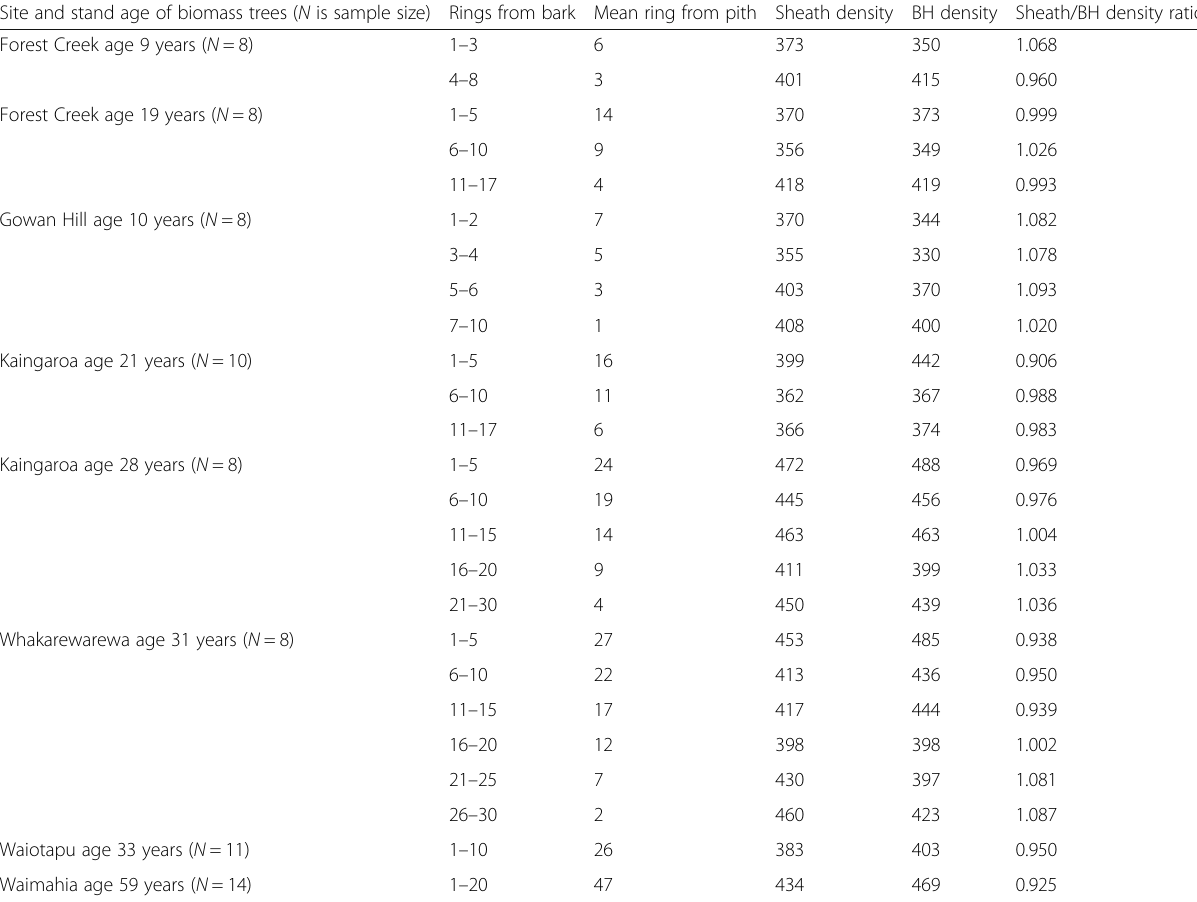
Table 6 Mean basic density at breast height and mean basic density of growth sheaths for given groups of rings (counted from bark), and the sheath/breast height (BH) density ratio for eight Douglas-fir stands in New Zealand Site and stand age of biomass trees ( N is sample size) Rings from bark Mean ring from pith Sheath density BH density Sheath/BH density ratio